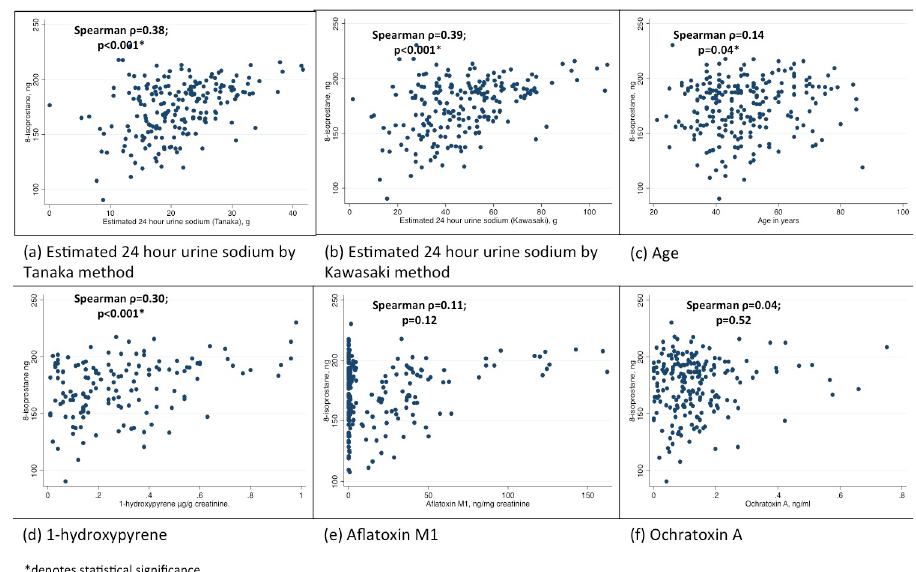
Fig 1. Correlations between urinary 8-isoprostanes levels and; (a) Estimated 24 hour urine sodium by Tanaka method, (b) Estimated 24 hour urine sodium by Kawasaki method (c) Age, (d) 1-hydroxypyrene, (e) Aflatoxin M1, (f) Ochratoxin A. � denotes statistical significance.